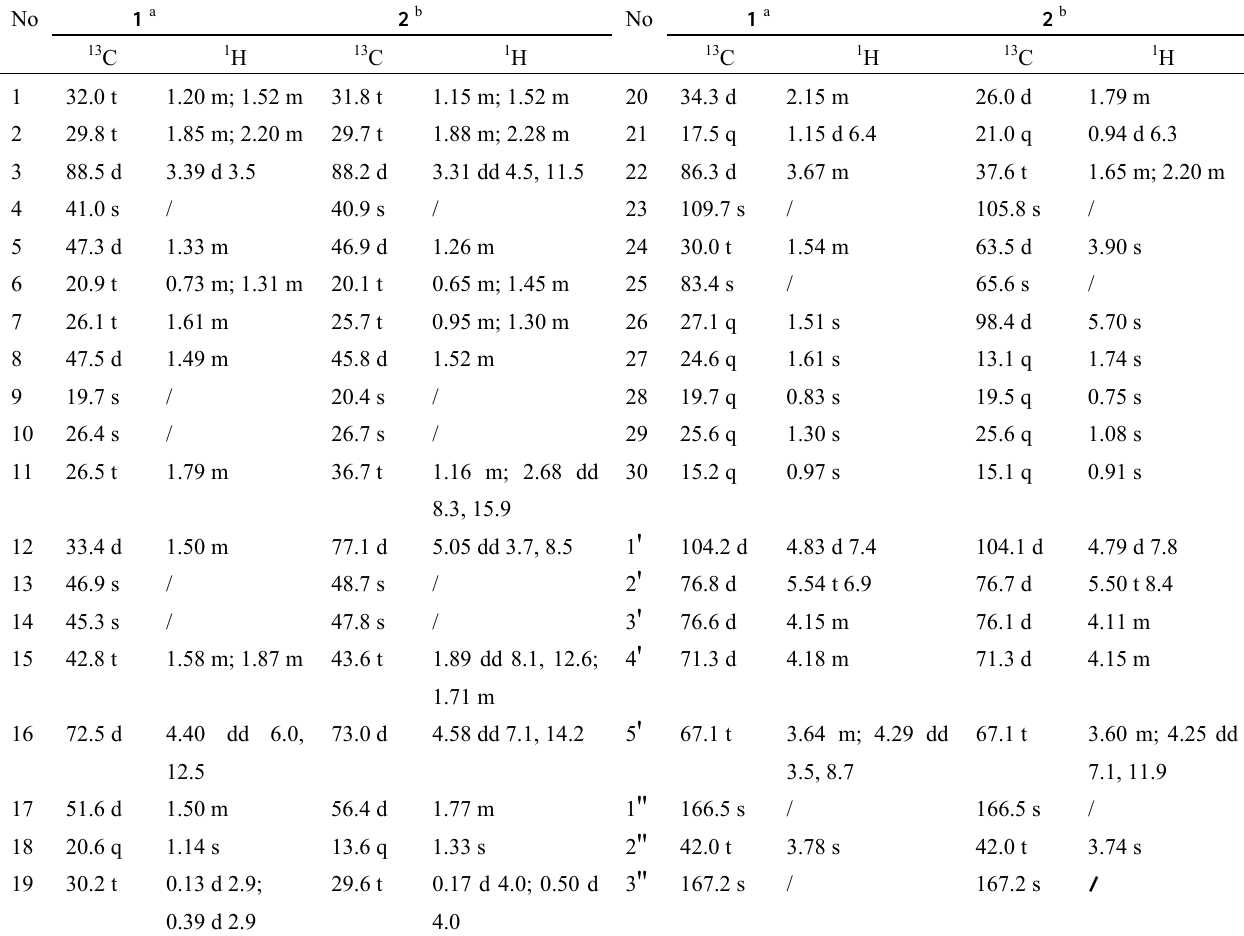
Table 1. The 1 H and 13 C-NMR data of 1 and 2 in C 5 D 5 N ( δ in